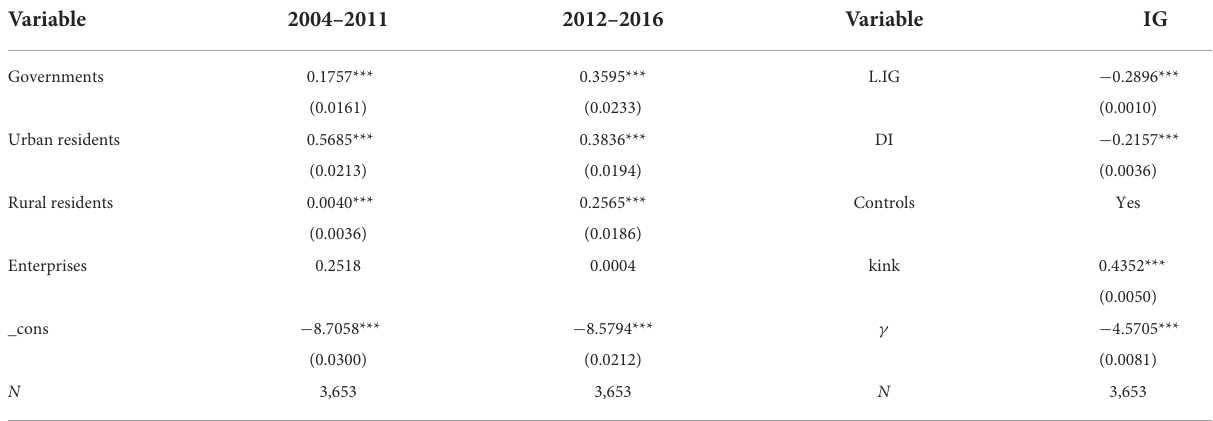
TABLE 6 Robustness